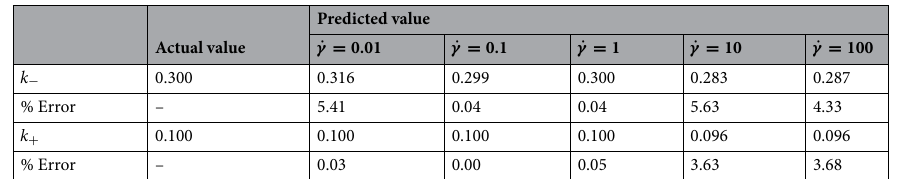
Table 3. RhINNs predicted values for k + and k − in different values of simple shear rate. For all cases G = 800 [ Pa ] , σ y = 20 [ Pa ] , η s = 20 [ Pa s ] , and η p = 20 [ Pa s ] are known from the material